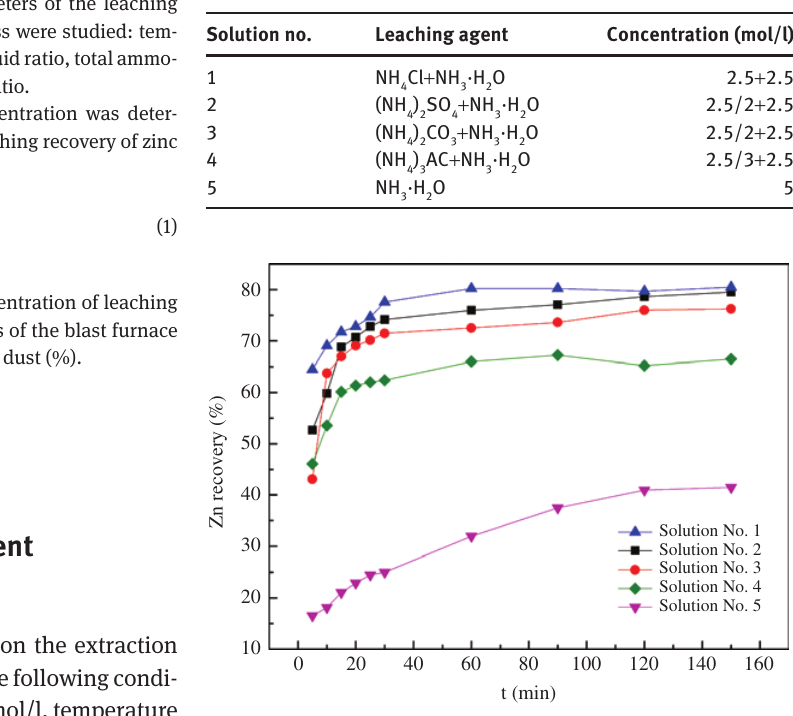
Table 2: The leaching reagent concentrations of different leaching